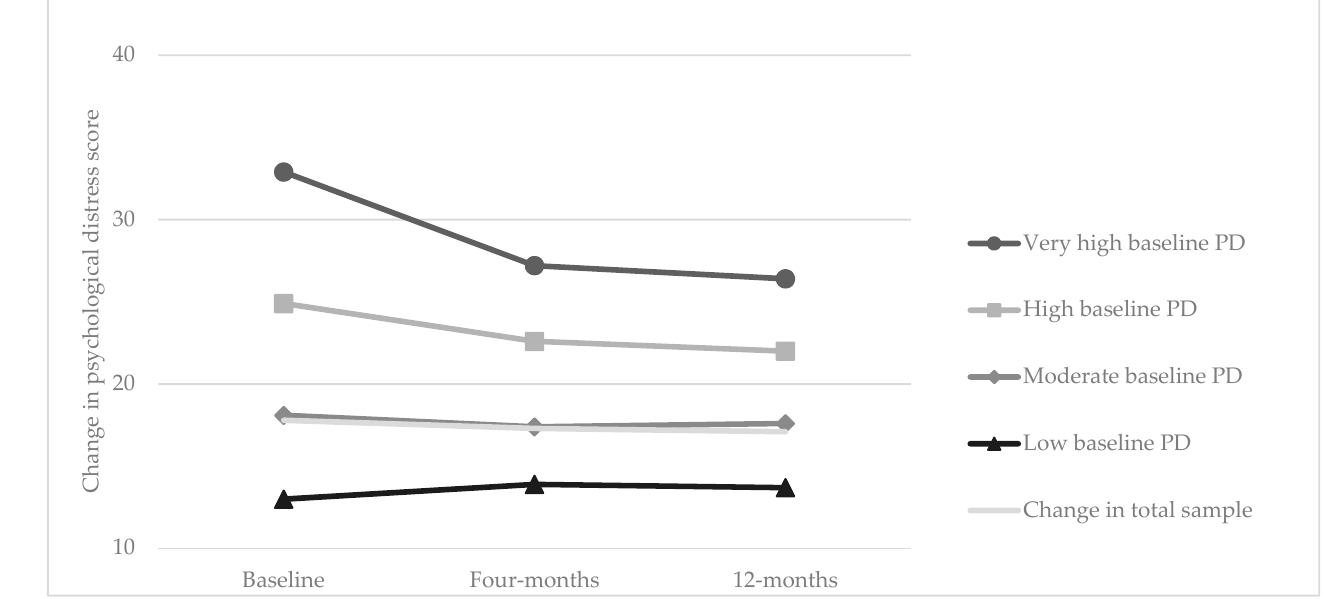
Figure 2. Change in psychological distress (PD) K10 score at baseline, 4 months and 12 months (n = 422) a . (a K10 completed at all three timepoints).